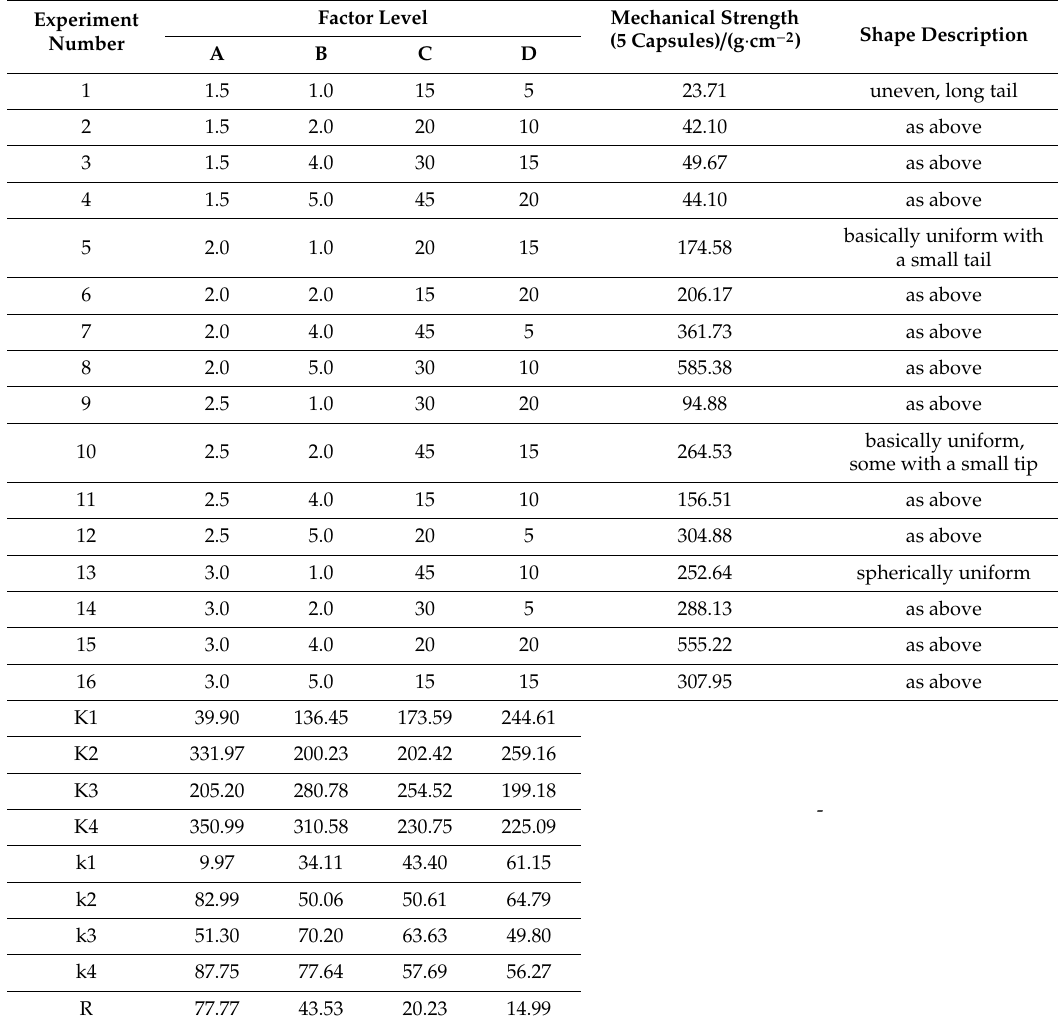
Table 2. Orthogonal experiments on the four factors a ff ecting the mechanical properties of the